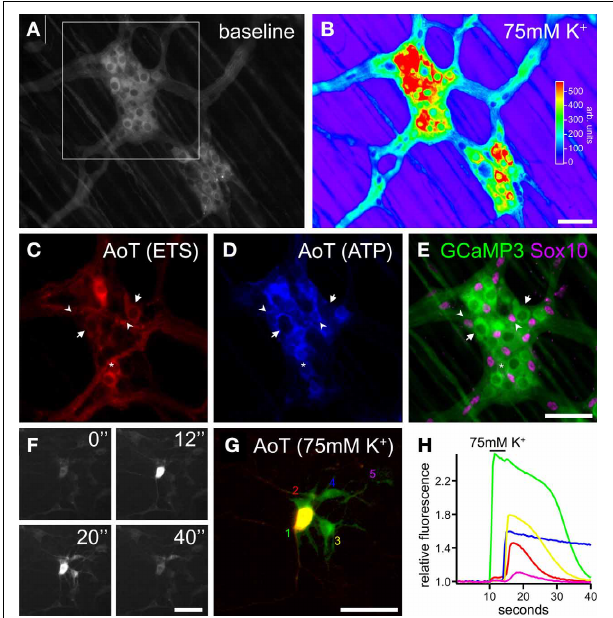
FIGURE 5 | Optogenetic Ca 2 + imaging of enteric neuron-glia crosstalk. (A) Gray scale image of myenteric plexus ganglia dissected from a Wnt1-Cre;R26R-GCaMP3 mouse colon displaying baseline GCaMP3 fluorescence. (B) False-colored image of fluorescence response to 75mM K + depolarization (5s) of the same ganglia as shown in (A) . (C,D) Activity over time (AoT) images of the myenteric ganglion in the frame indicated in (A) in which only pixels responding to electrical stimulation (ETS, 2s, 20Hz) of an interganglionic connective ( C , red, see also Supplementary movie 2) or local ATP (10 μ M, 20s) stimulation ( D , blue, see also Supplementary movie 3) are shown. (E) GCaMP3 fluorescence image of the same ganglion as in (C) and (D) immunostained for Sox10 (magenta). Arrows indicate enteric neurons displaying a Ca 2 + transient upon electrical stimulation only. Arrowheads point to enteric glial cells responding to ATP stimulation. Asterisk indicates an enteric neuron that responds to both electrical and purinergic stimulation. (F) Gray scale images of a patch of cultured myenteric neurons and glia established from a Wnt1-Cre;R26R-GCaMP3 animal, before (0 (cid:2)(cid:2) ), during (12 (cid:2)(cid:2) ), and after (20 (cid:2)(cid:2) , 40 (cid:2)(cid:2) ) stimulation with 75mM K + (5s). (G) AoT image of the cells shown in (F) responding immediately (red) or with a delay (green) to 75mM K + . See also Supplementary movie 4. (H) Recordings of the GCaMP3 responses to 75mM K + of one neuron and four surrounding enteric glial cells [color-coded numbers in (G) ]. Neurons typically show an immediate Ca 2 + transient to 75mM K + while enteric glial cells only respond with a delay, thus indicating neuron-to-glia communication. The slow downstroke of glial cell 4 (blue) could potentially be a sign of perturbed Ca 2 + homeostasis or a general decline in cellular health. Note that post-hoc examination of cellular identity is redundant because of the genetically-imposed reporter expression. Scale bars: 50 μ